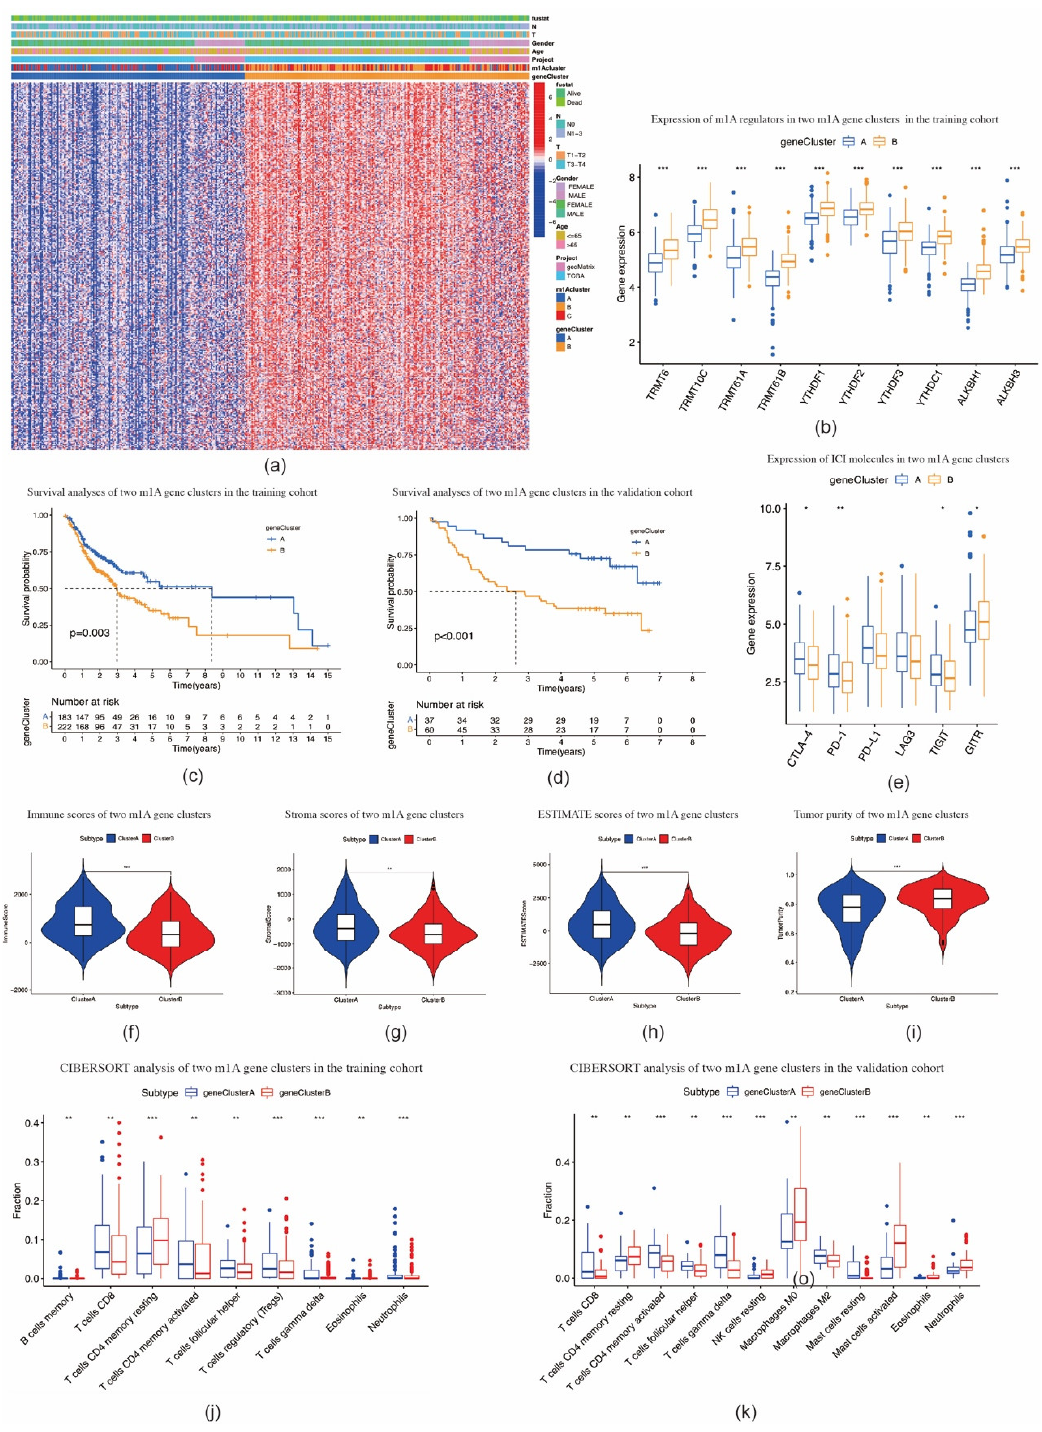
Figure 5. Construction of m1A gene signatures. ( a ) Heat map of consensus clustering of m1A phenotype–related genes to divide patients with oral squamous cell carcinoma into two genomic subtypes. ( b ) The expression of 10 m1A methylation regulators between two m1A modification genomic clusters. ( c ) The overall survival for 405 patients with oral squamous cell carcinoma within different m1A modification genomic clusters ( p = 0.003, log–rank test). ( d ) The overall survival for patients with oral squamous cell carcinoma in the validation cohort within different m1A modification genomic clusters ( p < 0.001, log–rank test). ( e ) The expression of immune checkpoint molecules in two m1A modification genomic clusters. ( f , i ) Violin plots show the immune, stroma, and ESTIMATE scores and tumor purity in two m1A modification genomic clusters. ( j , k ) The fraction of tumor–infiltrating lymphocyte cells in m1A modification genomic clusters in training cohort ( j ) and validation cohort ( k ) using the CIBERSORT algorithm. * p < 0.05; ** p < 0.01; *** p <